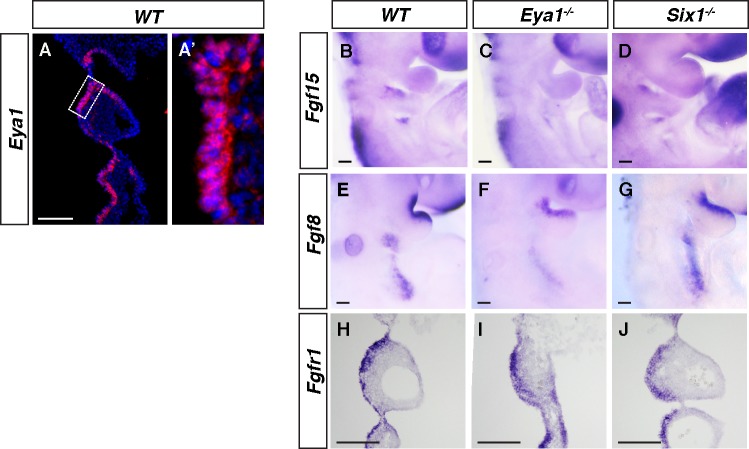
Expression of Eya1, Fgf8, Fgf15, and Fgfr1 in the pharyngeal ectoderm of E9.5 embryos.(A) Immunostaining for Eya1 on coronal section of WT embryos at E9.5 (n = 5). The region demarcated by white dotted box in (A) is magnified in (A’), showing expression of Eya1 protein in both the cytoplasm and the nucleus. (B–J) In situ hybridization of Fgf15, Fgf8 and Fgfr1 on whole mount or coronal sections of WT, Eya1-/- and Six1-/- embryos at E9.5 (n ≥ 5). Scale bars, 100 µm.